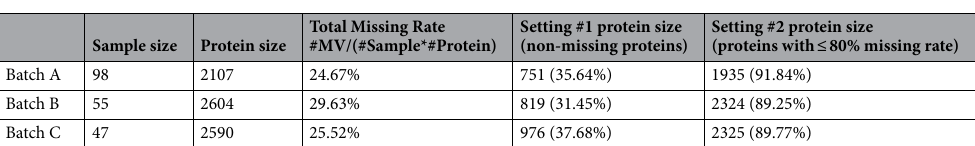
Table 1. Summary of real proteomics datasets used in this work